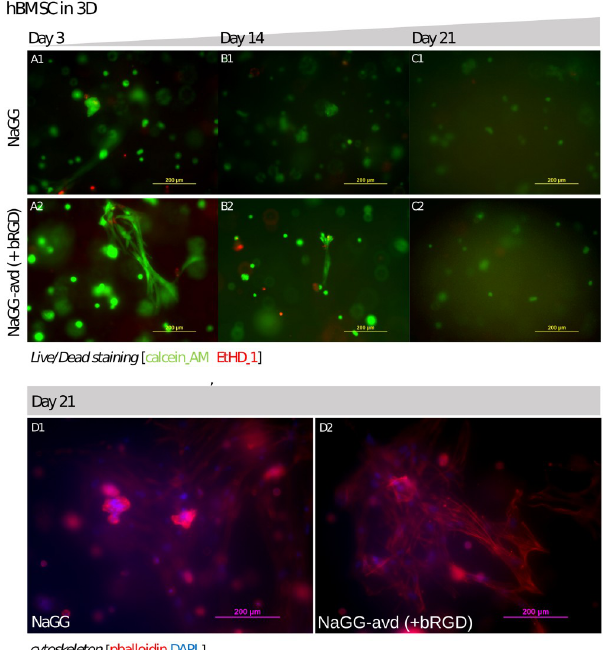
Fig 7. hBMSC encapsulation results (A1-C1 and A2-C2) LIVE/DEAD 1 stain of hBMSC encapsulated in NaGG (control) and NaGG-avd with bRGD over 21 days. Red stain = dead cells, Green stain = live cells. (D1-D2) Immunocytochemical cytoskeleton staining on day 21. Blue = cell nuclei (DAPI) and Red = actin filaments (phalloidin-TRITC).